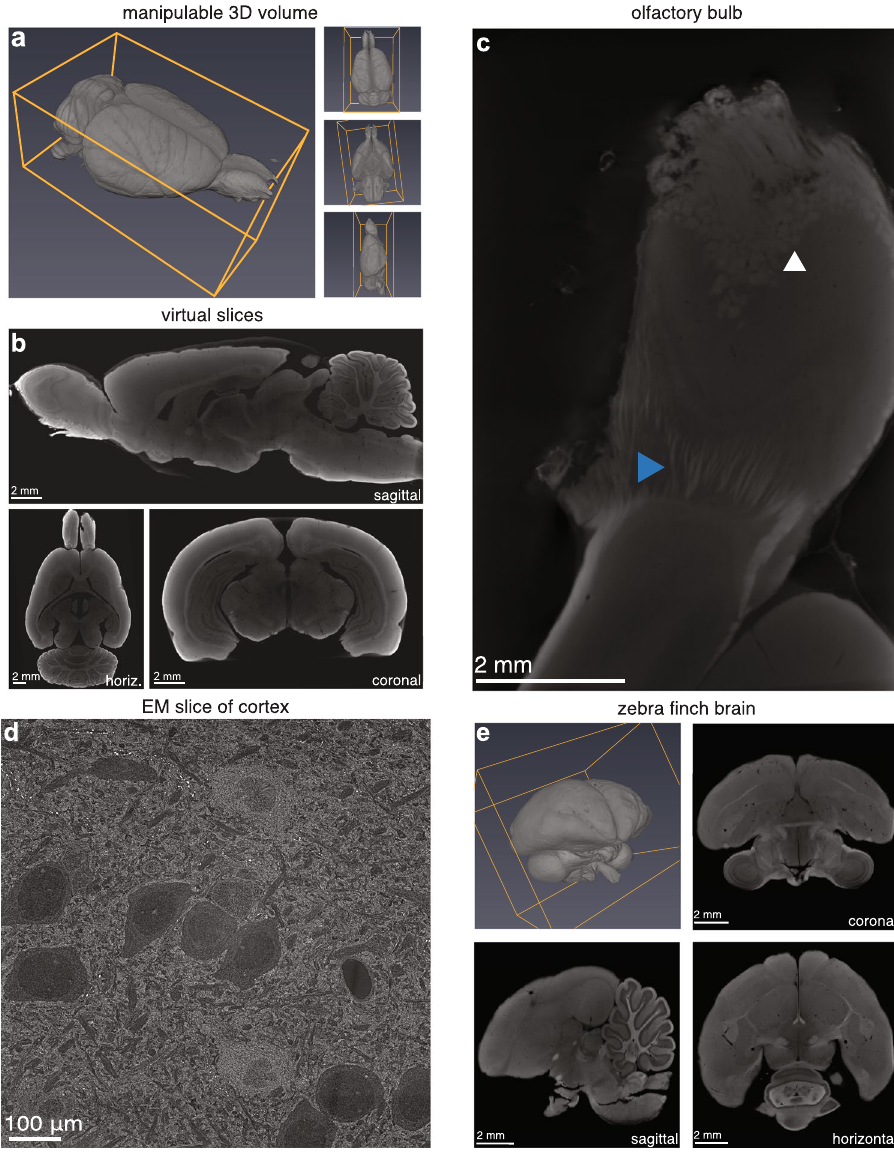
Figure 2. Capabilities of lesion characterization through micro-CT imaging. ( a ) Manipulable 3D volume and ( b ) virtual slices (13.9 μ m voxels) at arbitrary orientations from a micro-CT scan of a Long-Evans rat. ( c ) Olfactory bulb scanned at higher resolution (4.9 μ m voxels) revealing glomeruli (white arrowhead) and individual nerve fibers (blue arrowhead). ( d ) Scanning electron microscope (SEM) image (10 nm/pixel) of visual cortex of rat brain prepared for micro-CT imaging. ( e ) Zebra finch ( Taeniopygia guttata ) brain prepared for micro-CT imaging; 3D volume and 2D slices (5.6 μ m voxels) in the coronal, horizontal and sagittal